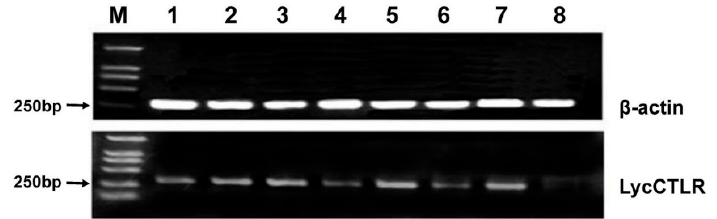
Figure 4. Expression analysis of LycCTLR gene in various tissues. Total RNA was extracted from eight tissues each from four normal fish, respectively, and RT-PCR was used to detect the expression levels of LycCTLR in various tissues. As a positive control for RT-PCR, β -actin was amplified to determine the concentration of templates. M: DNA Marker; 1. Gills; 2. Intestine; 3. Liver; 4. Kidney; 5. Heart; 6. Spleen; 7. Muscle; 8. Blood.